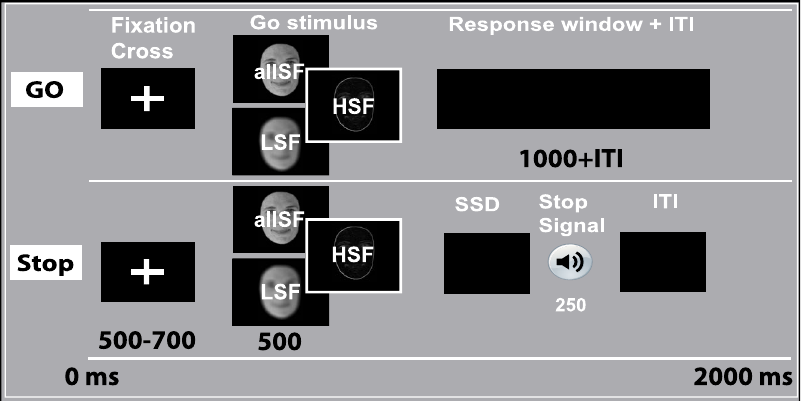
Figure 3. Visual stop-task. Each trial started with a white fixation-cross followed by a male or female face stimulus, indicating a left or right response. During stop trials, a tone was played at some delay (SSD) and instructed participants to suppress the indicated response. The presented face stimulus contained allSF, only LSF, or only HSF information. Prints underestimate the contrasts used in the current experiment, especially for the LSF and HSF pictures. The letters displayed on each face are only included here for clarity and were not on top of the faces during the experiment.